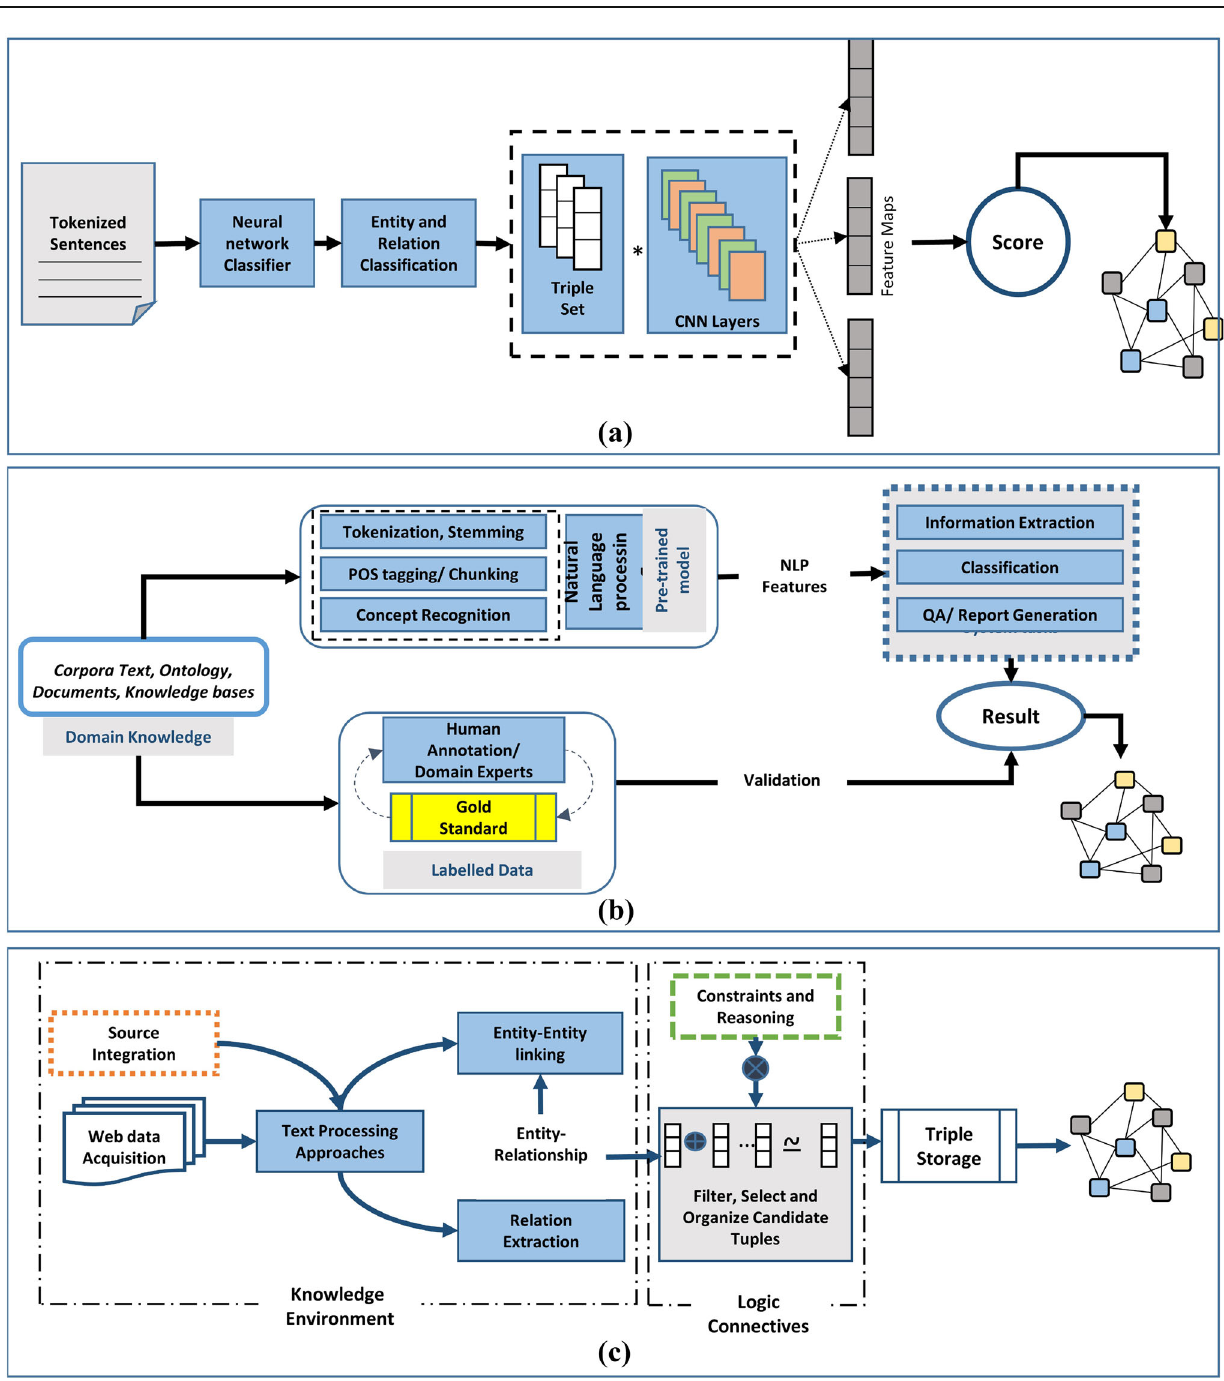
Fig. 4 Algorithmic view of a neural network-enabled KG creation, b natural language processing-enabled KG creation, c rule learning-based knowledge graph